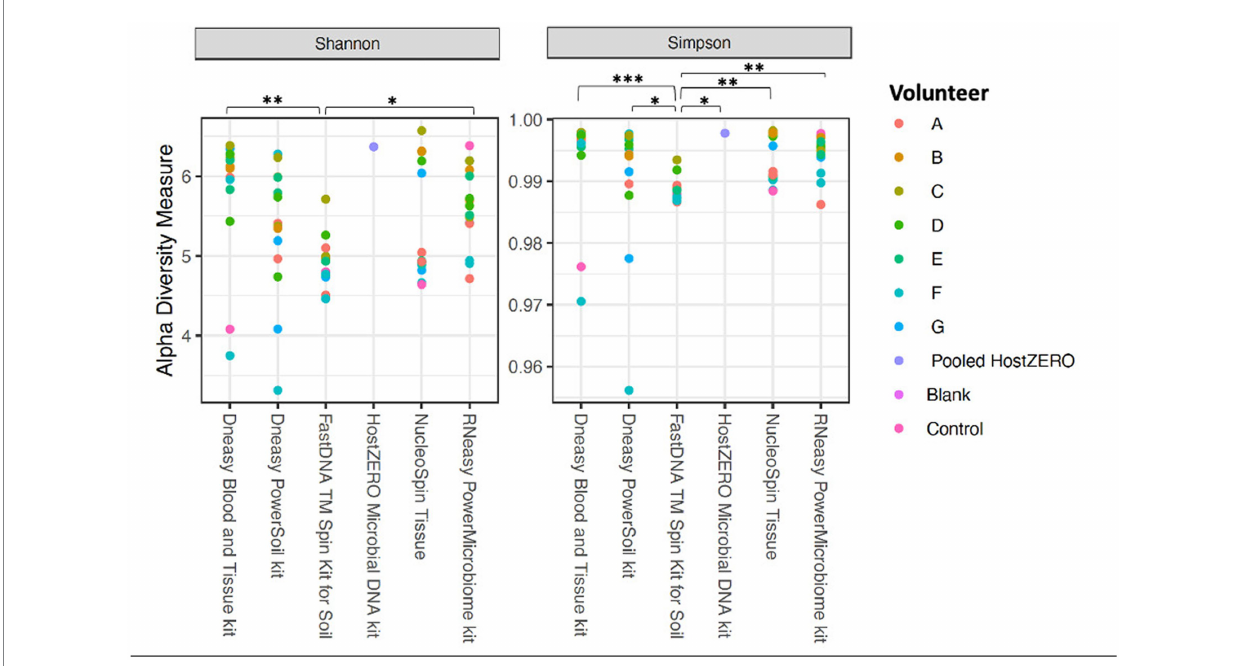
FIGURE 3 Alpha diversity measures (Shannon and Simpson diversity indices) per used extraction protocol. Shannon diversity was significantly lower for FastDNA compared to Blood & Tissue and RNeasy. When looking at Simpson diversity, FastDNA was significantly lower compared to Blood & Tissue, PowerSoil, HostZERO, NucleoSpin and RNeasy. There were no significant differences for observed richness. * p < 0.05, ** p < 0.01, *** p < 0.001.